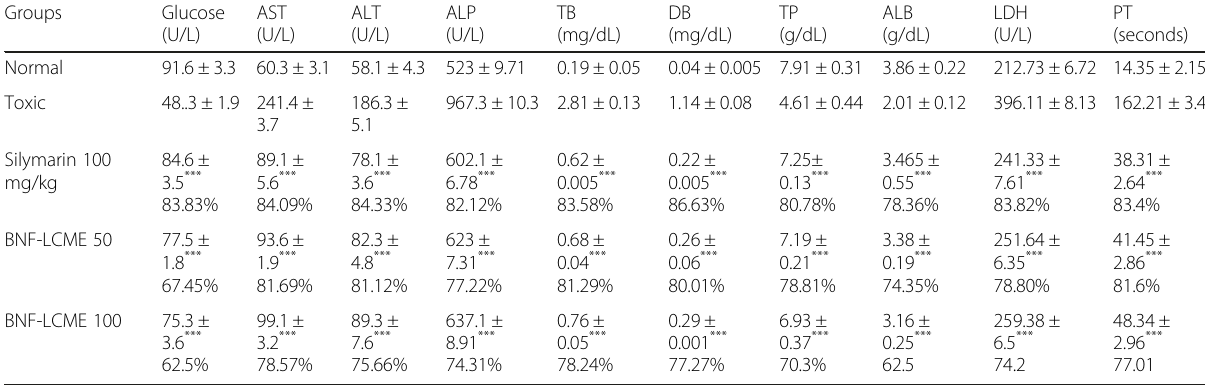
Table 4 Effect of BNF-LCME on different serum biochemical parameters and prothrombin time in D-galactosamine induced hepatotoxicity in